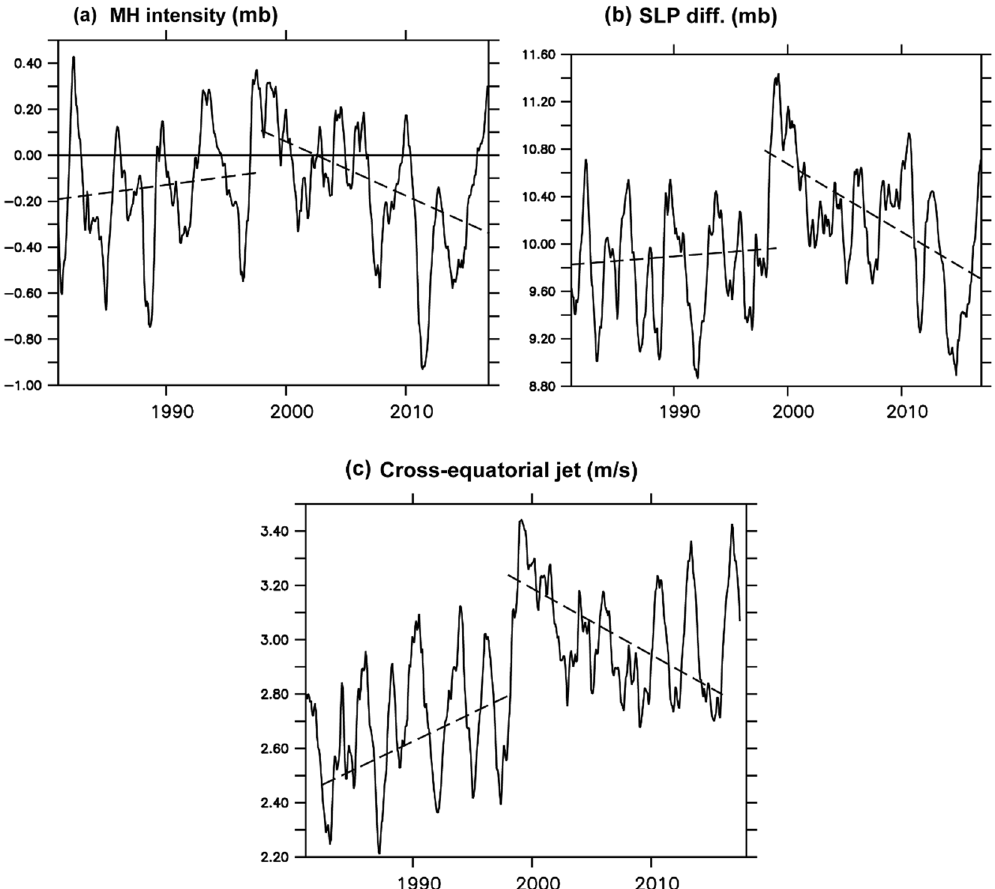
− − Q represents the air-sea heat flux term, ∇ Τ − ⋅ u In Eq. (1), represents the horizontal advection term m m ρ 2 represents the diffusion term, and − Δ w T e represents the entrainment term. The (zonal and meridional), κ∇ T m h m mixed layer depth was computed based on the 0.03 kg m − 3 density criteria. T m is the mixed layer temperature, ρ 0 is the reference seawater density which is taken as 1027 kgm − 3 , k is the eddy diffusivity (500 m 2 s − 1 ), C p is the specific heat capacity of water at constant pressure (4000 Jkg − 1 K − 1 ), h m is the mixed layer depth, w e is the entrain- ment velocity, and Δ T is the temperature difference between the mixed layer bottom and the layer just below the mixed layer. q( − h m ) denotes the downward radiative heat flux at the bottom of the mixed layer. It is based on the assumption of exponential decay with depth 35 . The term is calculated using the equation, − = + − γ γ − − q here, q(0) is the short wave radiative heat flux at sea surface and R , γ 1 , γ 2 are the constants 0.67, 1 and 17 respectively 14 . The oceanic advection term ∇ Τ ⋅ u (zonal and meridional) was computed using the ORAS4 currents m m where ∇ Τ is the temperature gradient. The entrainment velocity w e , is calculated from the equation of continu- m ity for an incompressible flow which is,